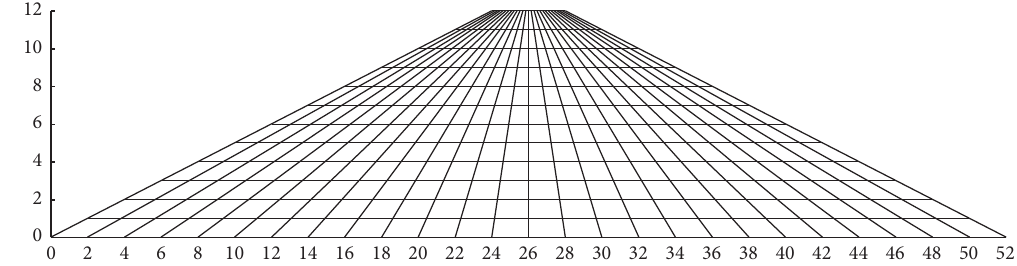
Figure 6: Divided cross section of a dam for an isoparametric element.